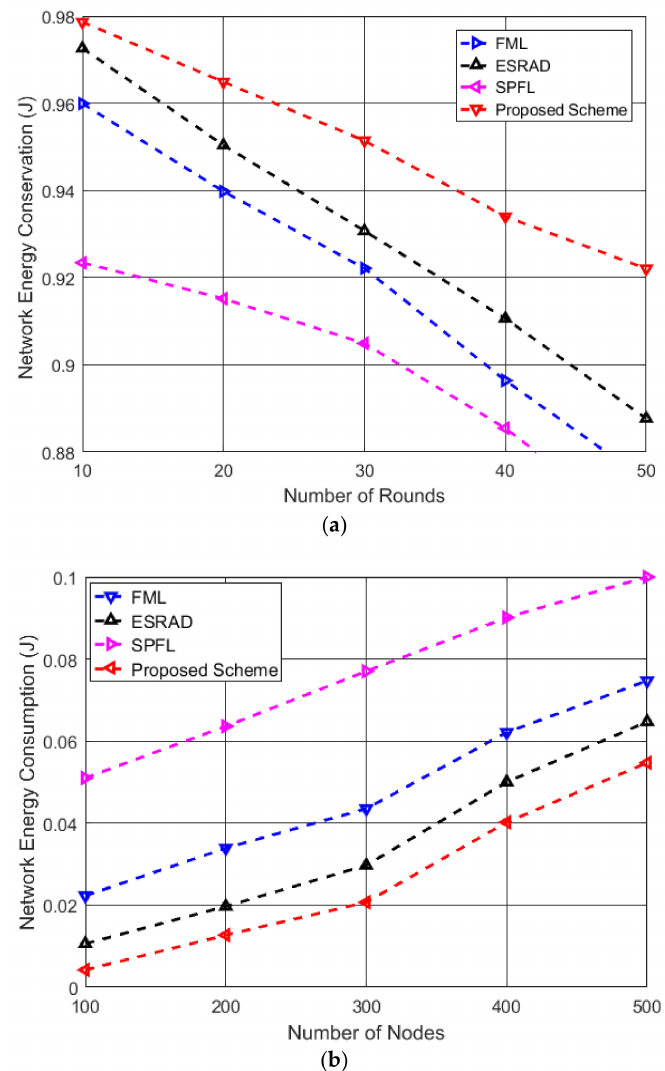
Figure 7. Performance comparison of network energy characteristics of the four algorithms: ( a ) network energy conservation with respect to number of rounds; ( b ) network energy consumption corresponding to number of nodes when the number of rounds is considered to be